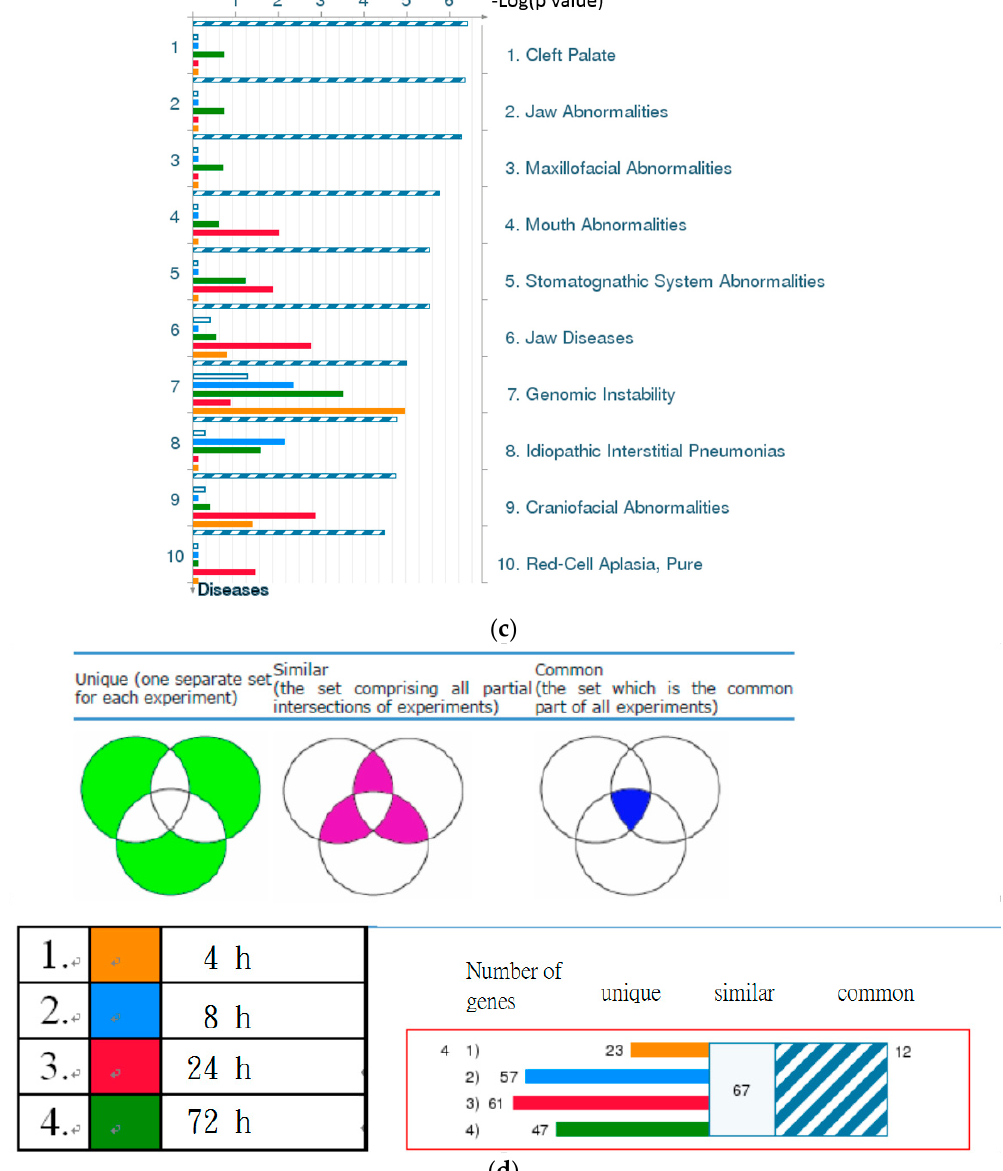
Figure 2. Results of the MetaCore™ analysis for all four time points post-TBI (4 h, 8 h, 24 h, and 72 h). All results are sorted according to those most strongly represented in the “common” set. ( a ) Pathway maps. Canonical pathway maps represent a set of signaling and metabolic maps that comprehensively cover human biological functioning. All maps are created by Thomson Reuters scientists using a high quality manual curation process based on published peer reviewed literature. Experimental data are visualized on the maps as blue (for downregulation) and red (upregulation) histograms. The height of the histogram corresponds to the relative expression value for a particular gene/protein; ( b ) Process networks. The content of these cellular and molecular processes is defined and annotated by Thomson Reuters scientists. Each process represents a pre-set network of protein interactions characteristic of that process; ( c ) Related diseases (determined based on biomarkers). Related disease folders are organized into a hierarchical tree. Gene content may vary greatly between such complex diseases as cancers and some Mendelian diseases. Also, coverage of different diseases in literature is skewed. These two factors may affect p- value prioritization for diseases; ( d ) Figure legend giving the meanings of the colors and statistical interpretation of the above three figures. These figures were generated by MetaCore™.